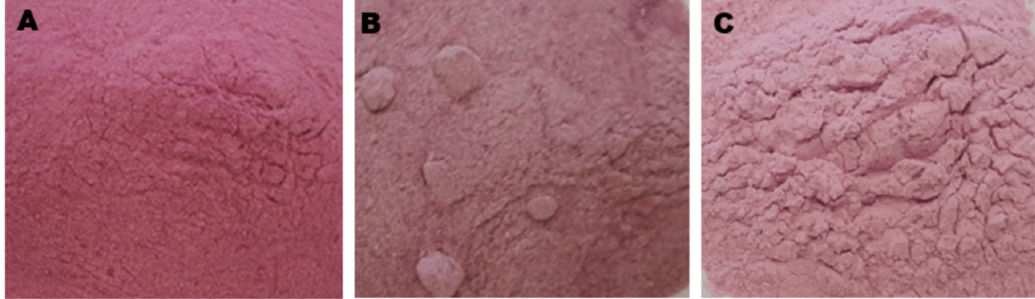
Figure 1. Freeze-dried pomegranate powder produced with ( A ) maltodextrin, ( B ) gum arabic and ( C ) waxy starch.